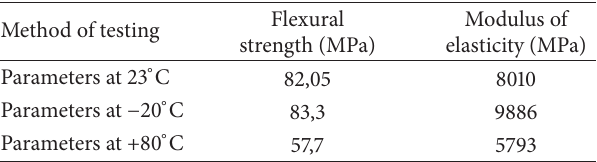
Table 3: The average results of the strength test of the Corian (PMMA/ATH) panels at different